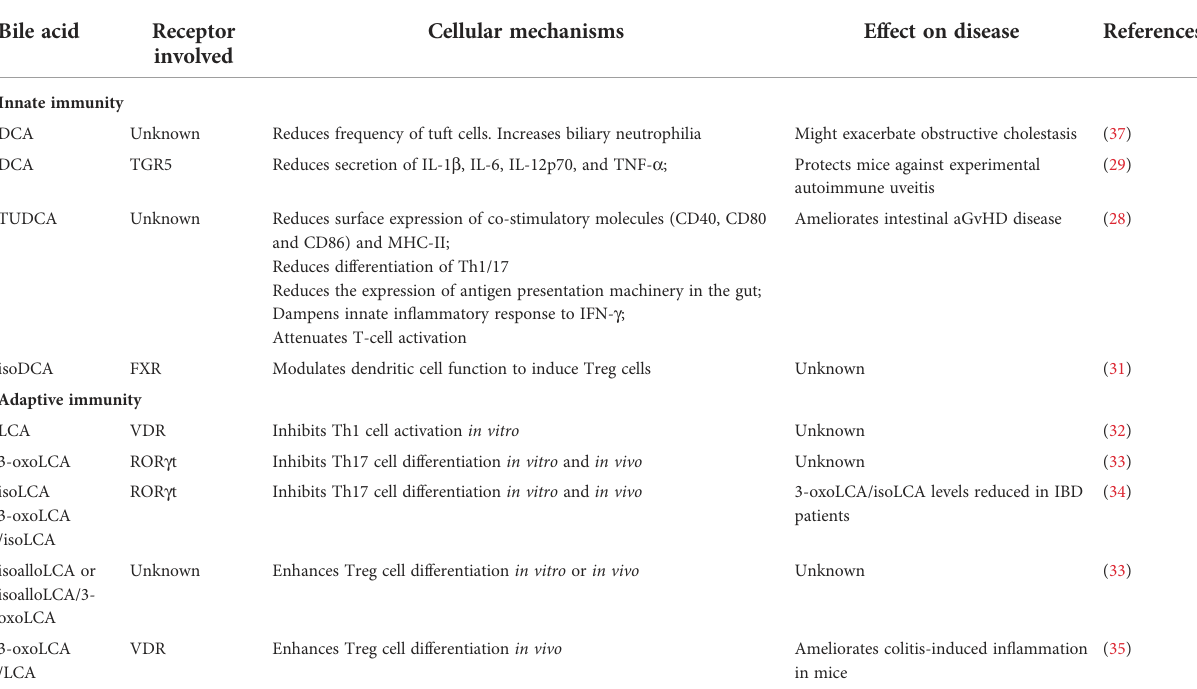
TABLE 2 Immunomodulatory properties of secondary bile